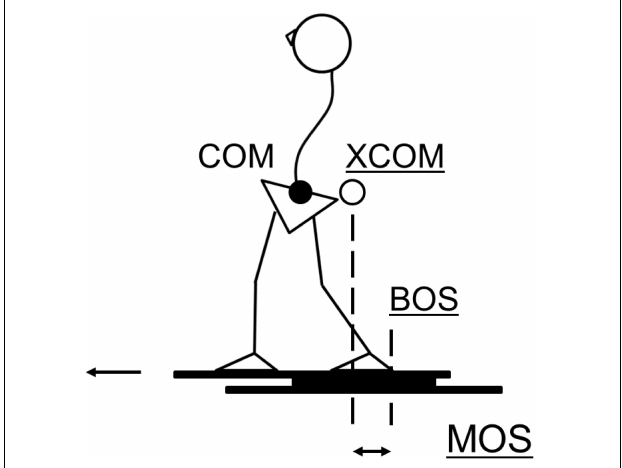
FIGURE 2 | Schematic diagram showing the parameters used to compute the margin of stability at backward initial contact in the antero-posterior direction. The MOS is calculated as follows: MOS = edge of BOS – XCOM, i.e., the difference between the two dashed lines. Edge of BOS is represented by the heel marker on the step leg. XCOM is computed using the formula (XCOM = dCOM + vCOM/ p g / l), where dCOM is the COM displacement, vCOM is the COM velocity, g is the acceleration of gravity, and l is the distance of the COM from the axis of the ankle joint in the sagittal plane. MOS, margin of stability; XCOM, extrapolated center of mass; BOS, base of support; COM, center of